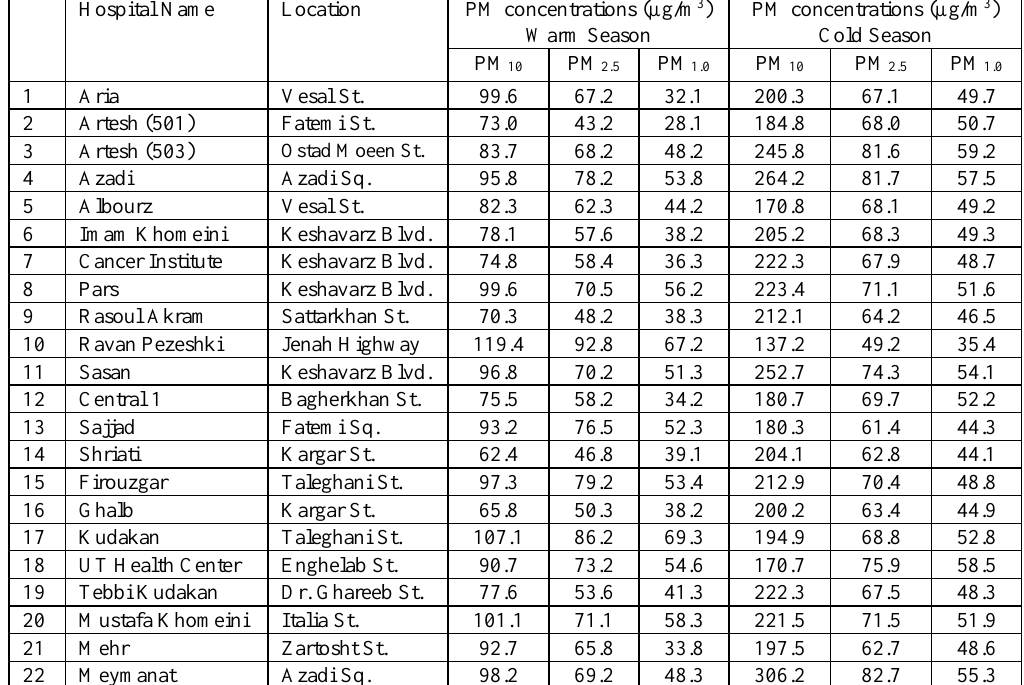
Table 2. Names, locations and mean concentration of PM 10 of the